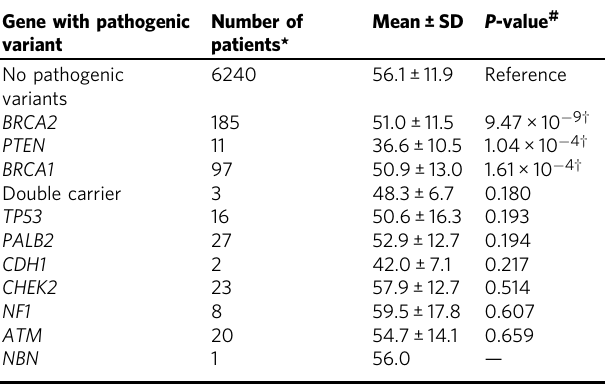
*The number of patients with age at diagnosis is shown # Mean age at diagnosis of each gene was compared with the patients without pathogenic variants by t